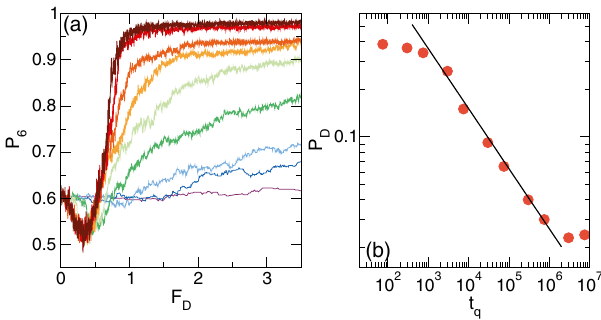
Fig. 5 Transition from the disordered to the ordered state for colloidal particles as a function of quenching speed. a The fraction of sixfold coordinated colloids P 6 versus driving force F D for a colloidal system with colloid density n c = 1.0, pinning density n p = 0.5, pinning force F p = 1.0, and pinning radius r p = 0.35 at quench times of t q = 3 × 10 6 , 7.5 × 10 5 , 3.0 × 10 5 , 7.5 × 10 4 , 3.0 × 10 4 , 7.5 × 10 3 , 750, 300, and 75, from top to bottom. b The defect density P D vs t q for the system in ( a ) obtained at F D = 2.5. The solid line is a power-law fi t with exponent β = − 0.39. Error bars representing the uncertainty in the defect density, obtained from multiple realizations, are smaller than the data markers.